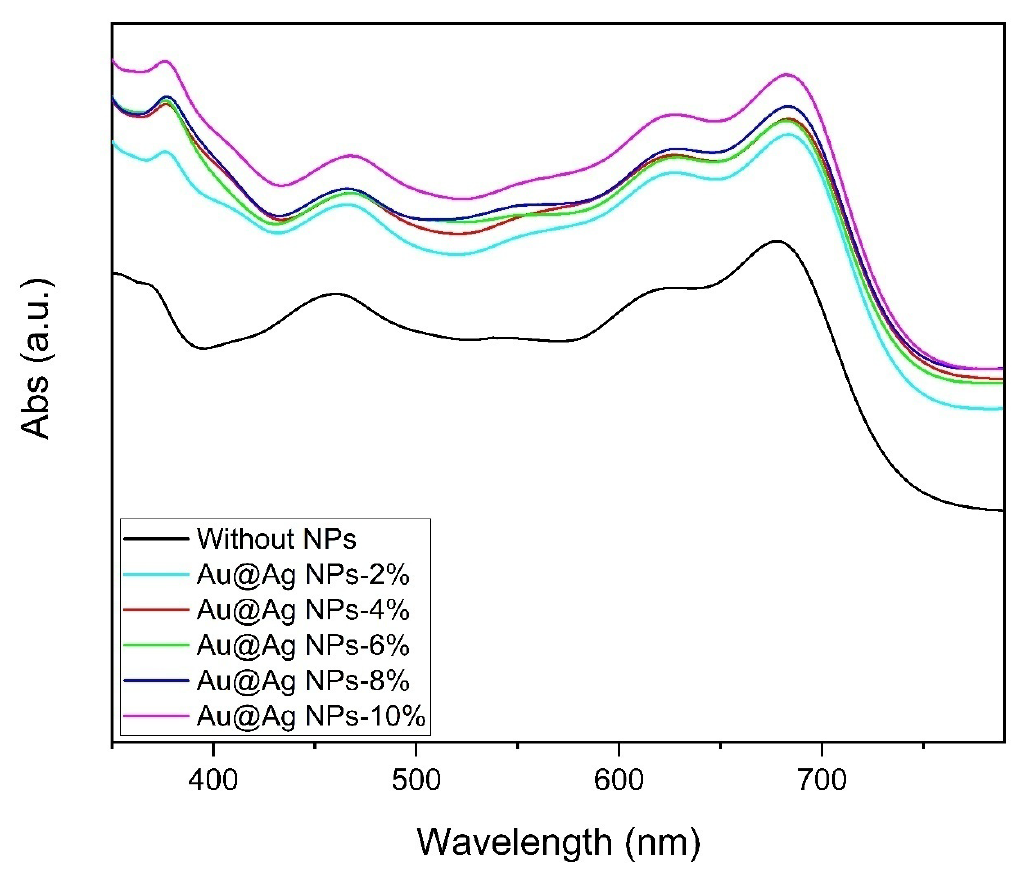
Figure 5. UV-Vis absorption profiles of the PSCs (ITO/PEDOT:PSS + Au@Ag NPs-14%/PTB7:PC 71 BM+ different amounts of Au@Ag NPs).